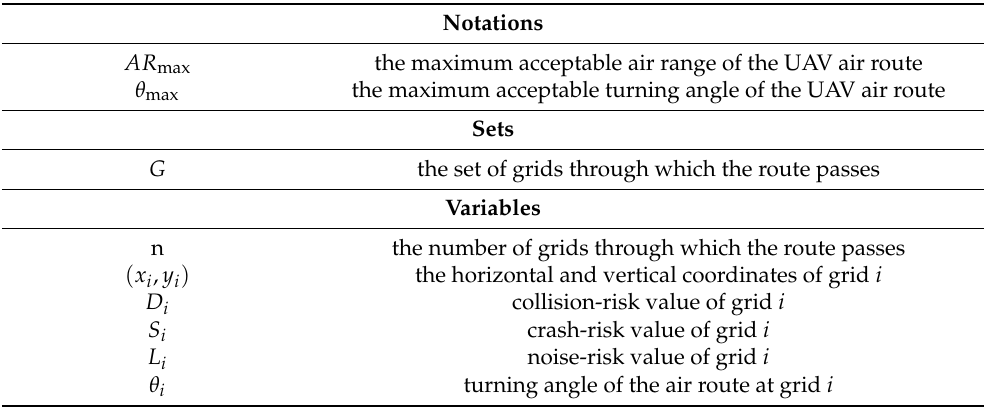
Table 3. Related parameters for single-air-route planning formulation